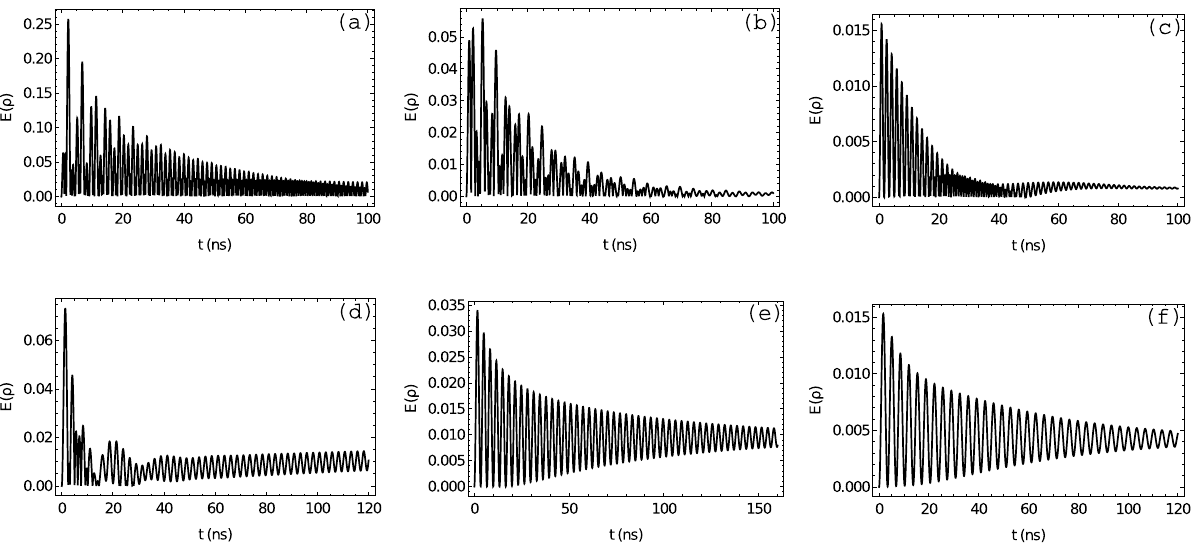
1 / 137 , ( b , e ) 3 / 137 , and α α ˜ = ˜ = 0.8 eV, ( c ) g 1.8 eV, ( d ) g 0.1 eV, = = = −